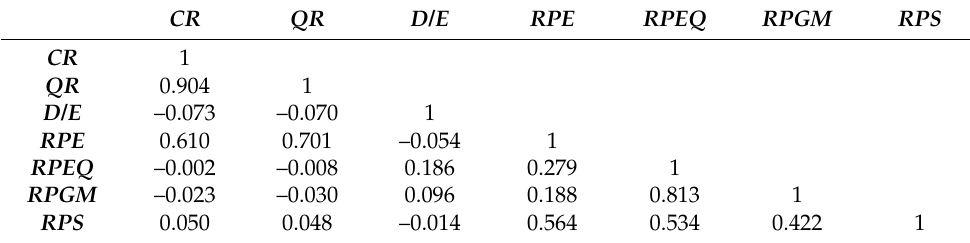
Table 9. Correlation matrix for all